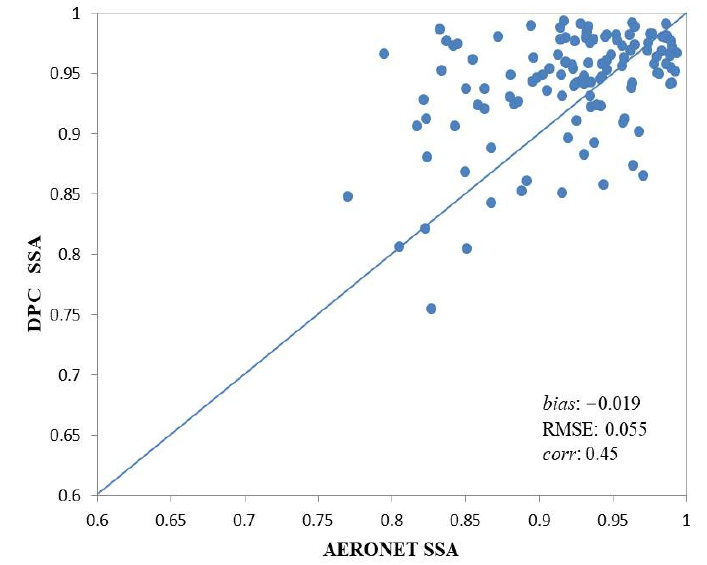
Figure 7. Comparison between aerosol SSA retrieved from DPC and AERONET.